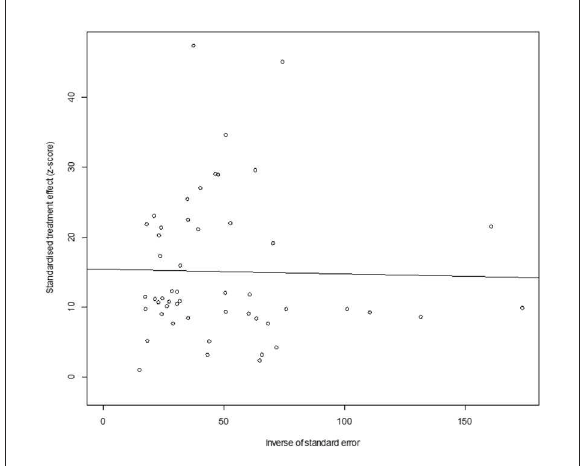
FIGURE3 Egger’s test for publication bias (decetion